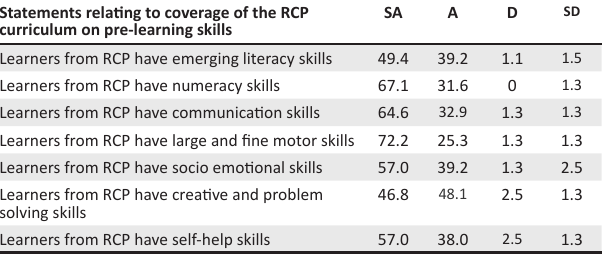
TABLE 2: Reception class programme teachers’ responses on the effectiveness of the reception class programme on